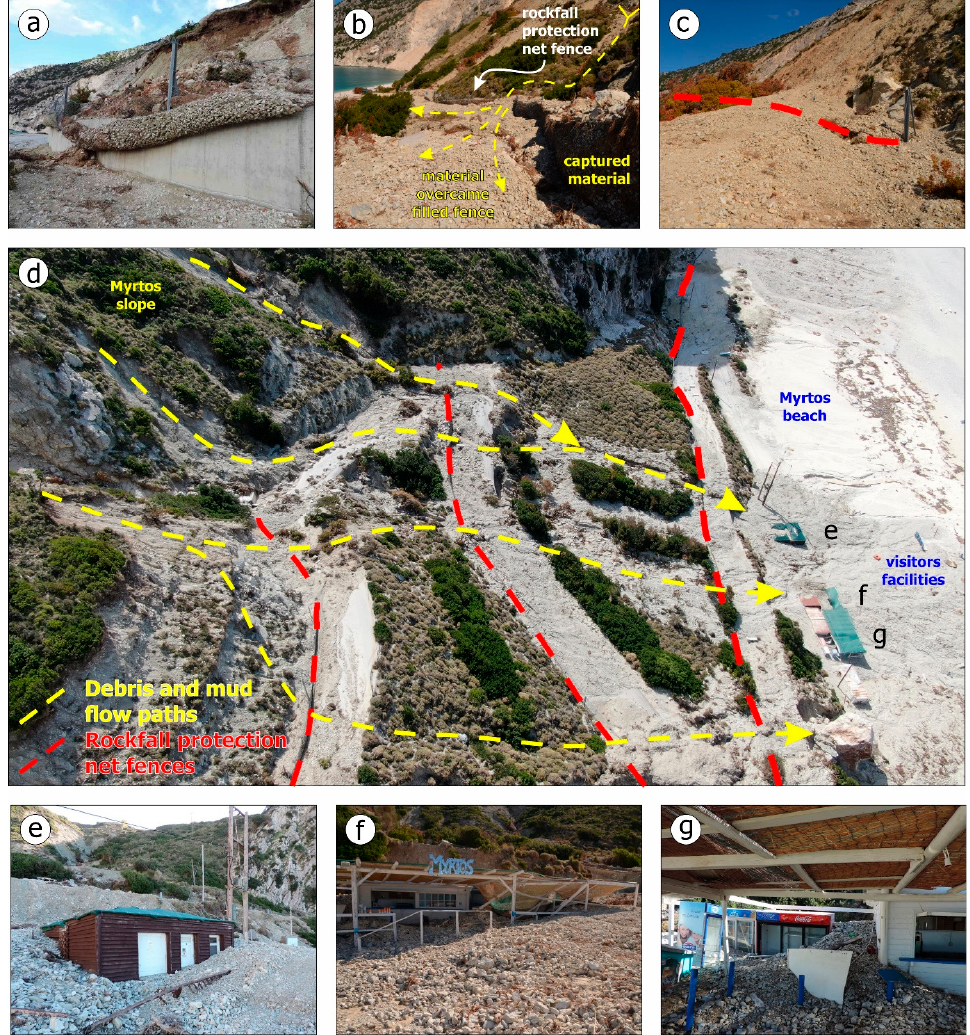
Figure 6. Characteristic views of ( a – g ) the impact of the debris and mud flows generated by Medicane Ianos on the rockfall protection net fences ( a – d ) and the visitor facilities along the beach ( d – g ). The slope protection works were disabled in several sites due to the large quantity of mobilized material, which partially covered large segments of the road ( d ) and also the tourist facilities and infrastructure at the base of the slope ( e – g ), which were almost buried in the deposits.